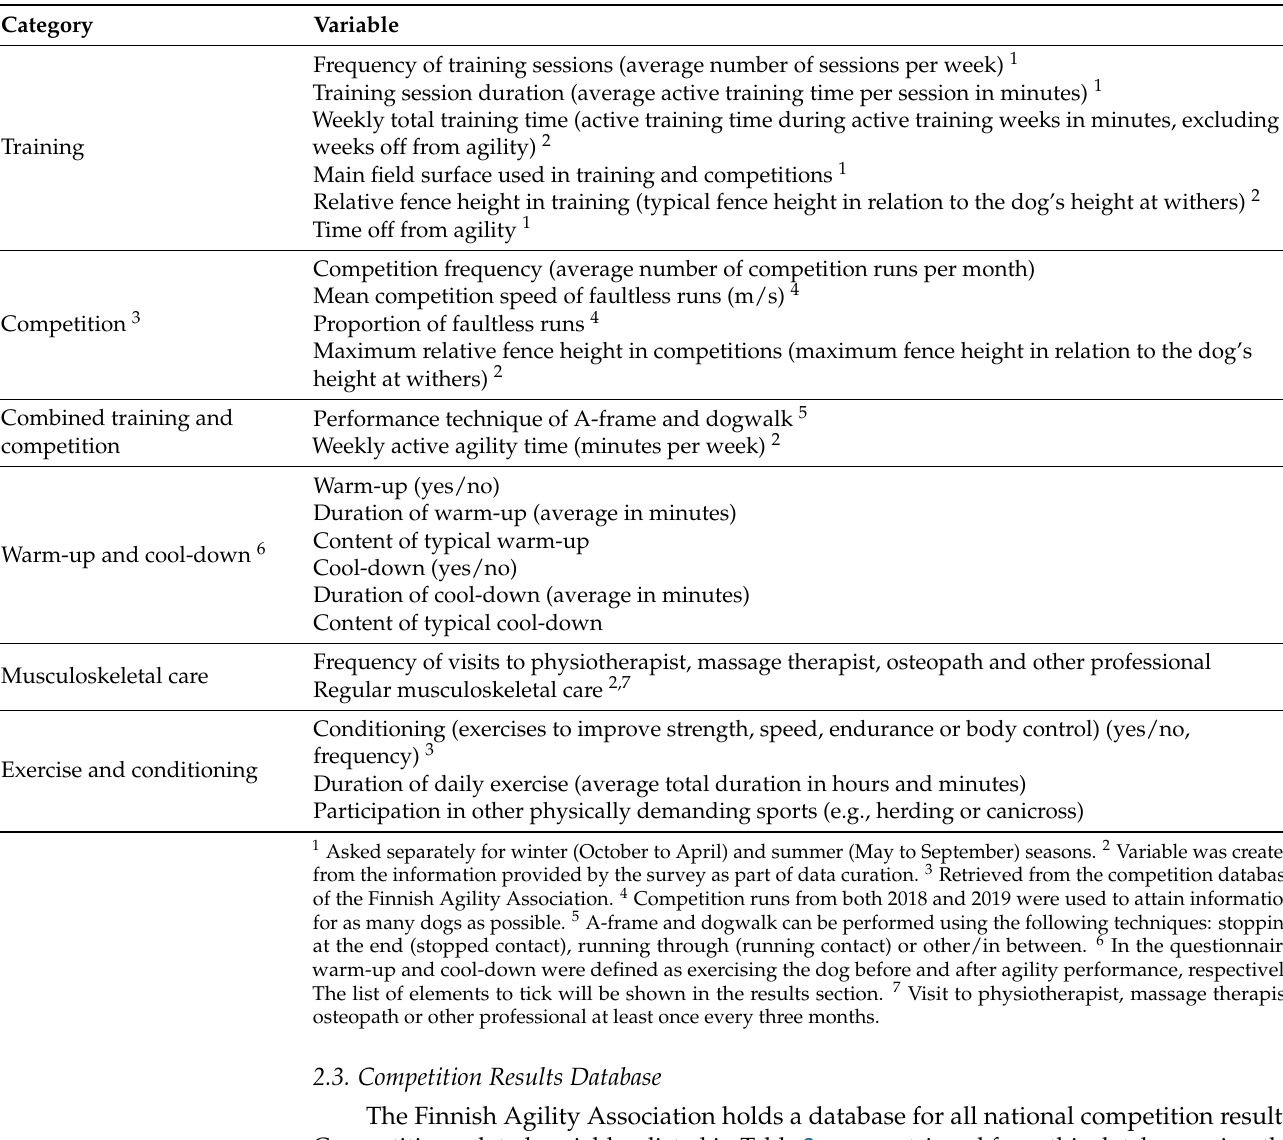
Table 2. Training, competition and management in